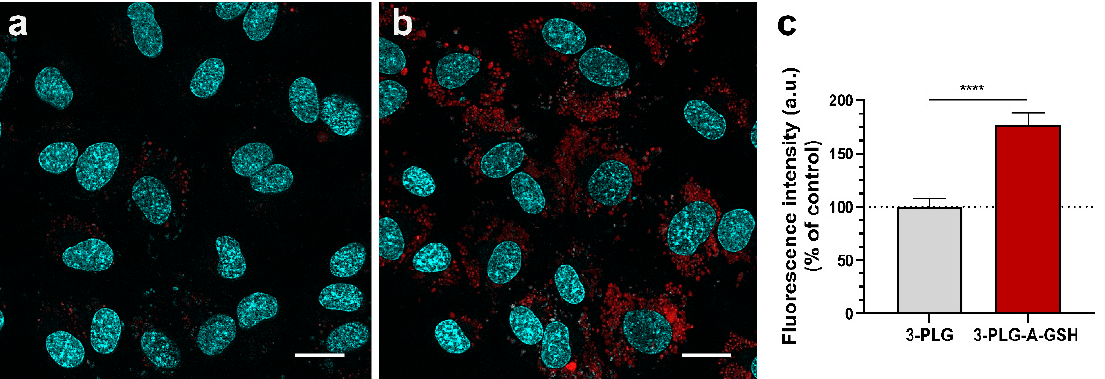
Figure 6. Confocal microscopy images showing the entry of ( a ) non-targeted (3-PLG) and ( b ) alanine–glutathione-targeted (3-PLG-A-GSH) nanocarriers labeled with R6G (red) into living human brain endothelial cells (100 μ g/mL; 24 h incubation). Cell nuclei are stained with Hoechst 33,342 (blue). Scale bar: 20 μ m. ( c ) Evaluation of the R6G fluorescence intensity of cells incubated with 3-PLG or 3-PLG-A-GSH (24 h). Values are means ± SD and given as arbitrary units (a.u.), shown as percentage of the 3-PLG group. Statistical analysis: unpaired t -test, **** p < 0.0001, compared to the 3 PLG group; n = 4.